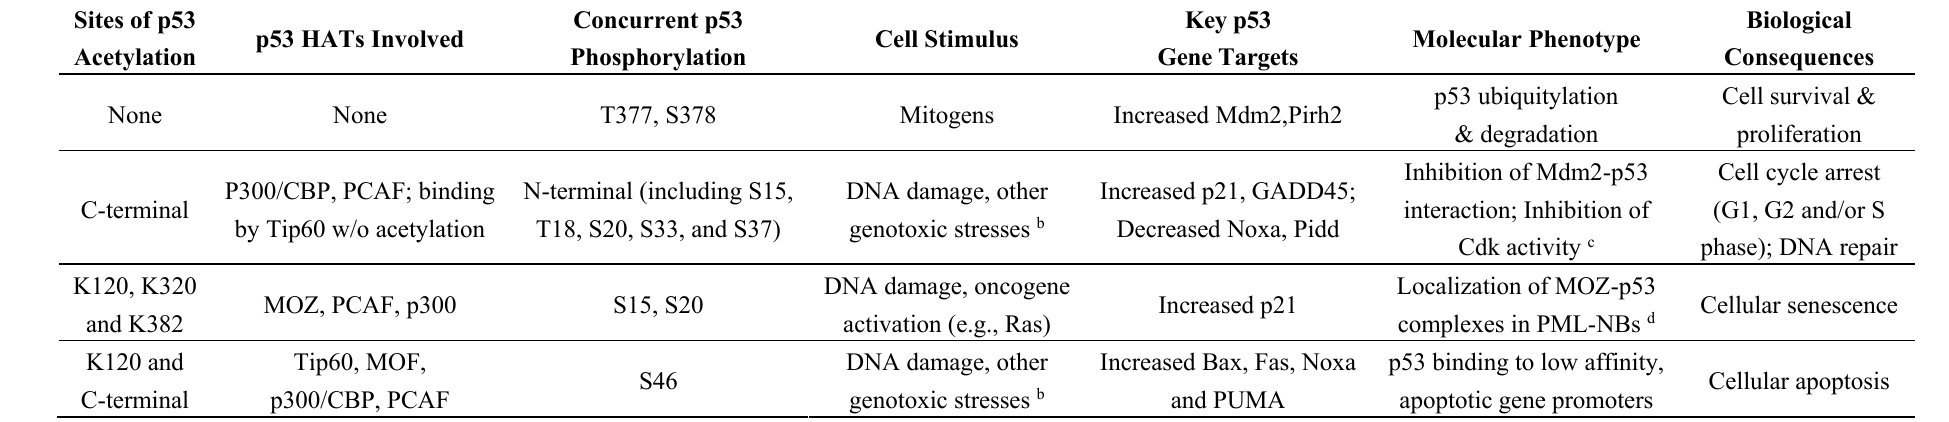
Table 1. Molecular and Cellular Consequences Associated with p53 Acetylation a